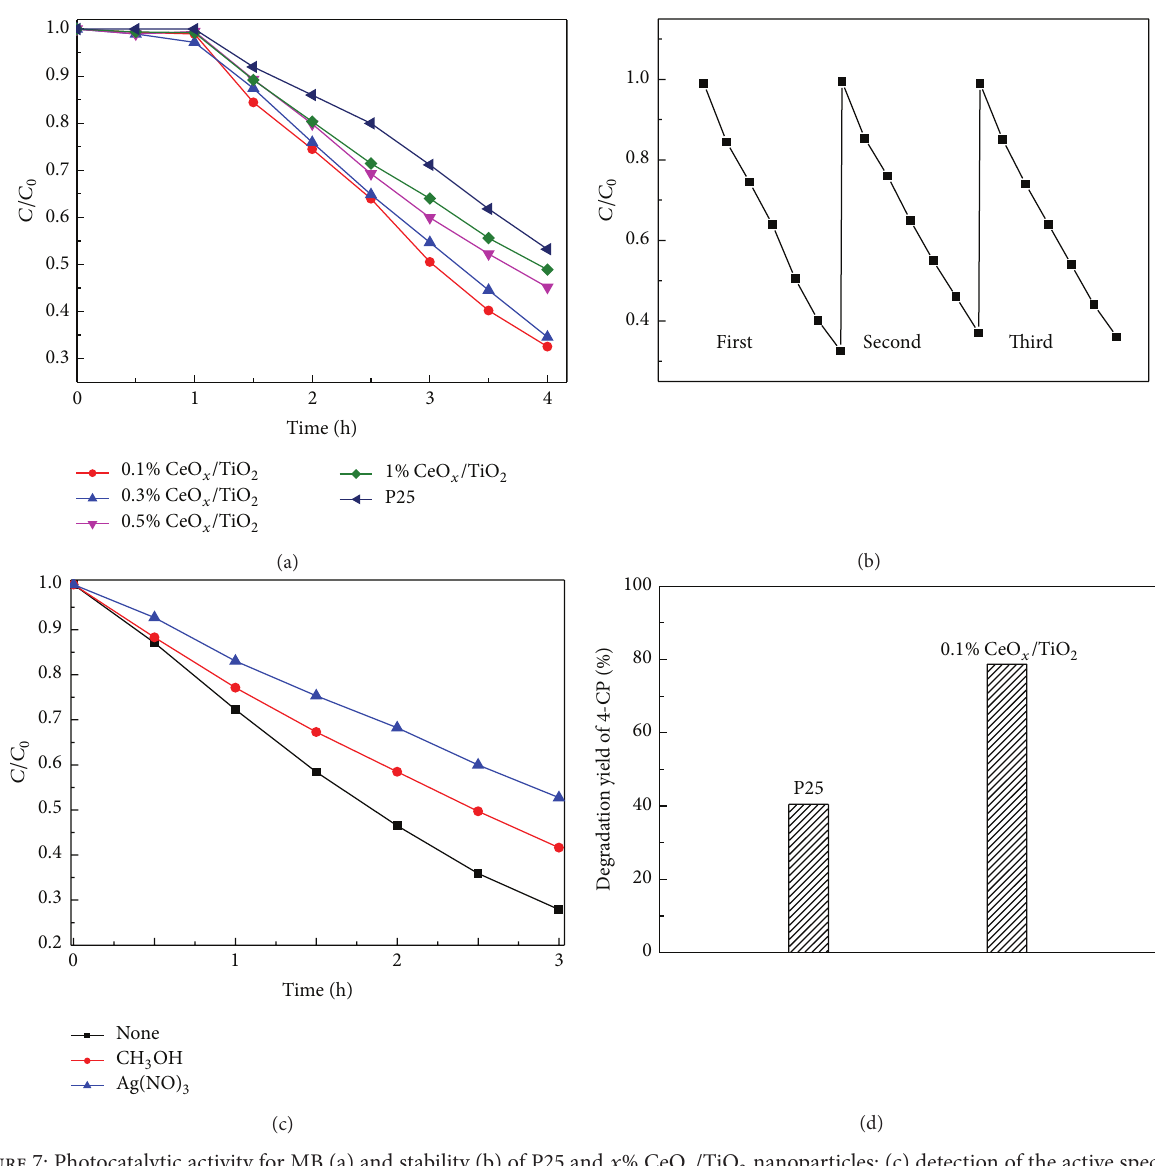
Figure 7: Photocatalytic activity for MB (a) and stability (b) of P25 and 𝑥 % CeO 𝑥 /TiO 2 nanoparticles; (c) detection of the active species of electrons and holes; (d) photocatalytic degradation yield of 4-CP on P25 and 0.1% CeO 𝑥 /TiO 2 nanoparticles.